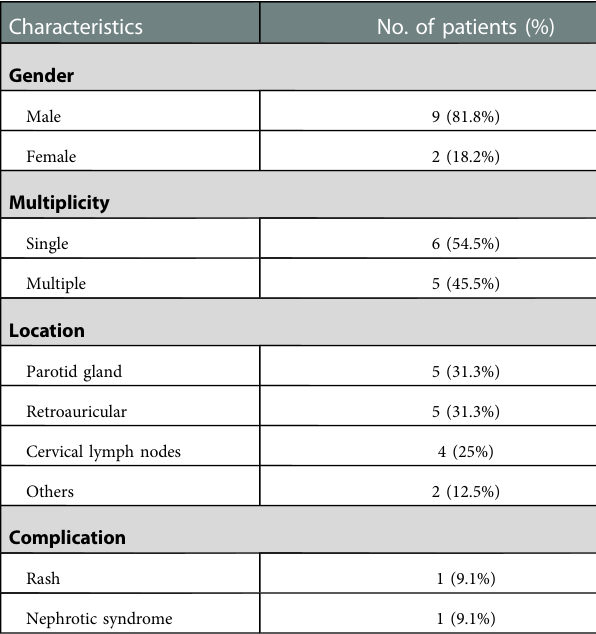
TABLE 2 The summary of clinical features. Characteristics